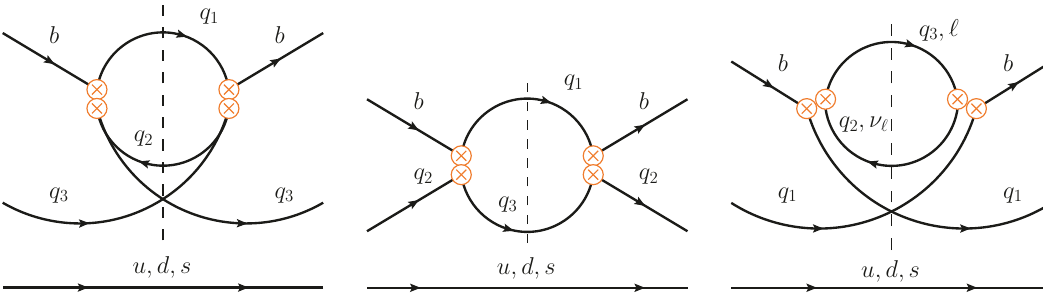
Figure 2 . Diagrams corresponding, from left to right, to the int − , exc, and int + topologies at LO-QCD. The numbering scheme for quarks follows that in eq. (2.3), so that q 1 , 2 are up-type quarks and q 3 is down-type. Note that semileptonic contributions only arise in the int + topology. Disregarding the second, non-interacting spectator quark, these topologies are related by crossing to those in meson decays, cf. footnote